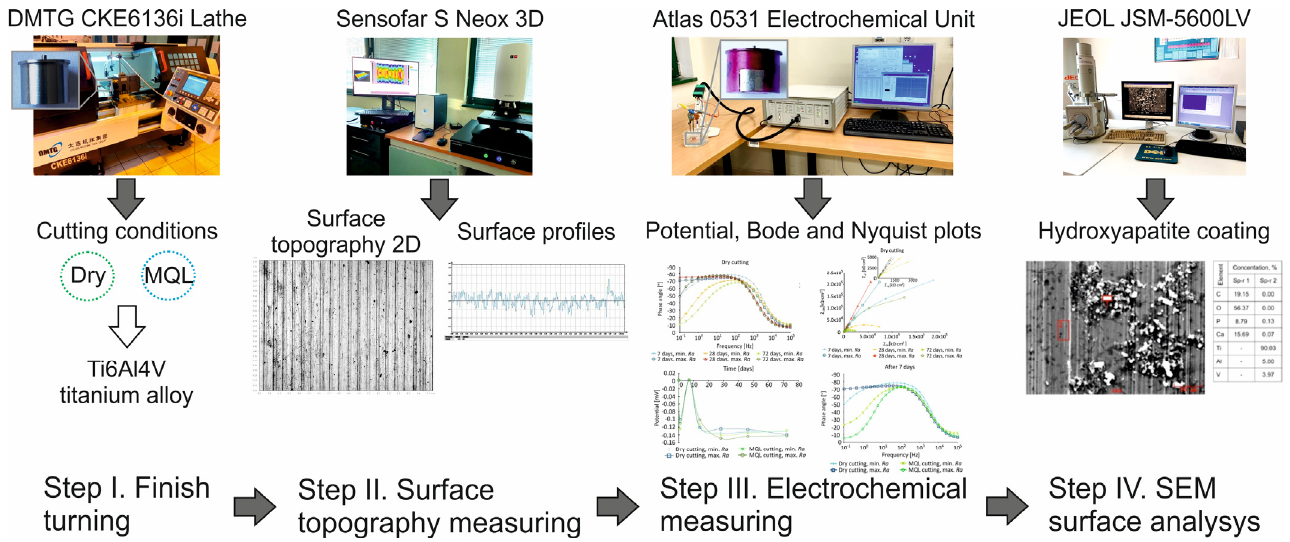
Figure 1. Experimental research plan.